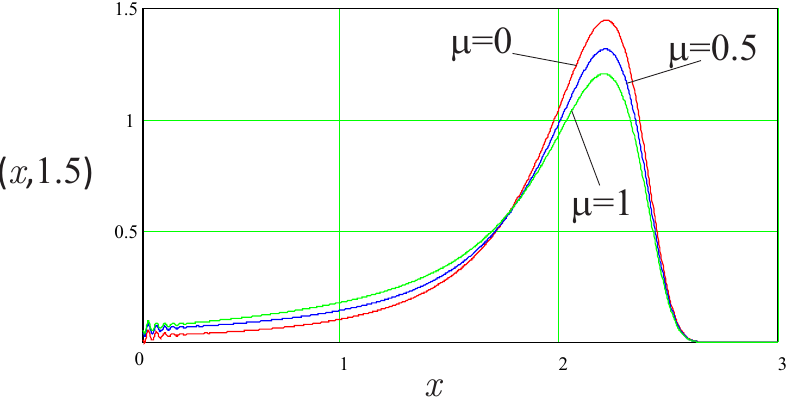
Figure 2. Solution (33) for several values of µ and for t = 1.5, a = 0.2, b = 1, α = 0.3.